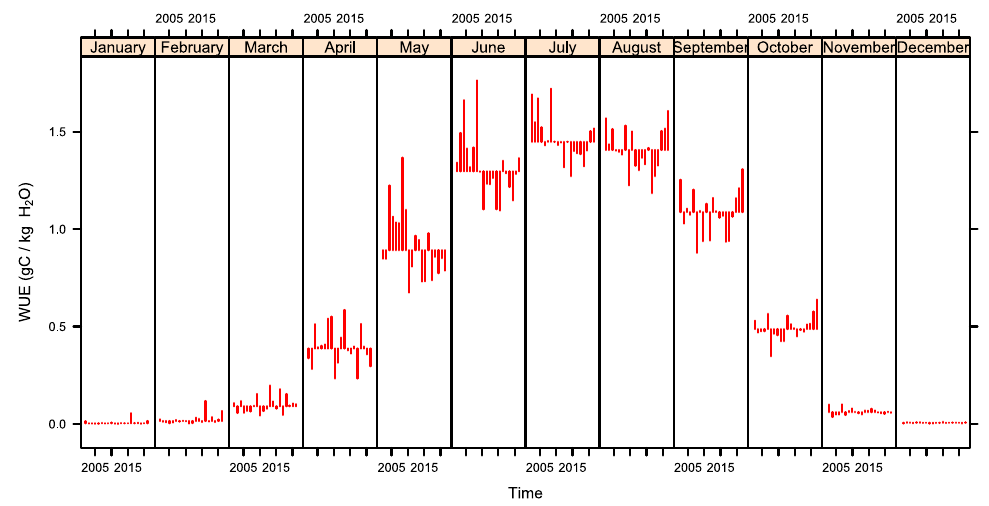
Figure 15. The monthly plot of the WUE time series.